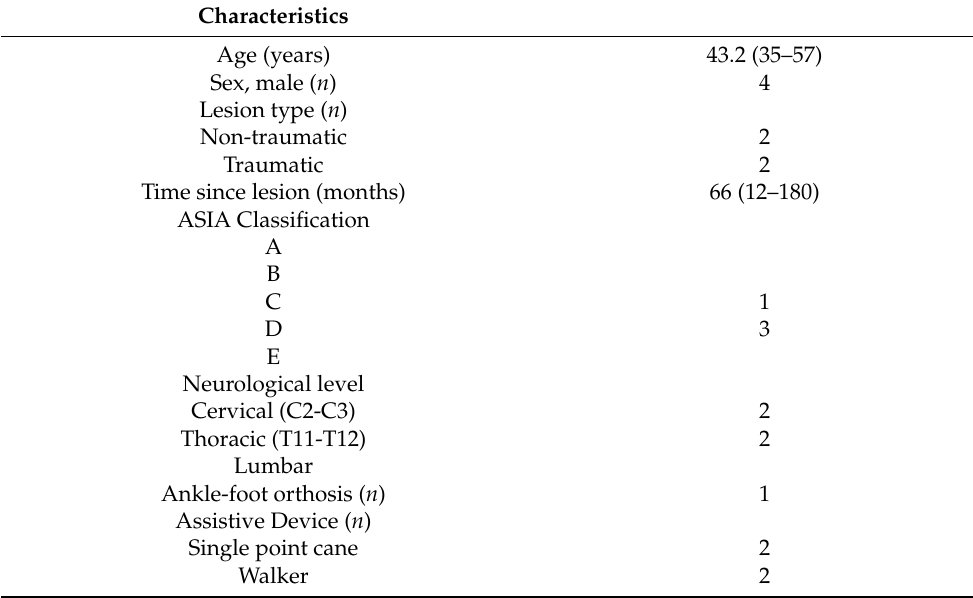
Table 1. Clinical and demographic characteristics of the sample 1